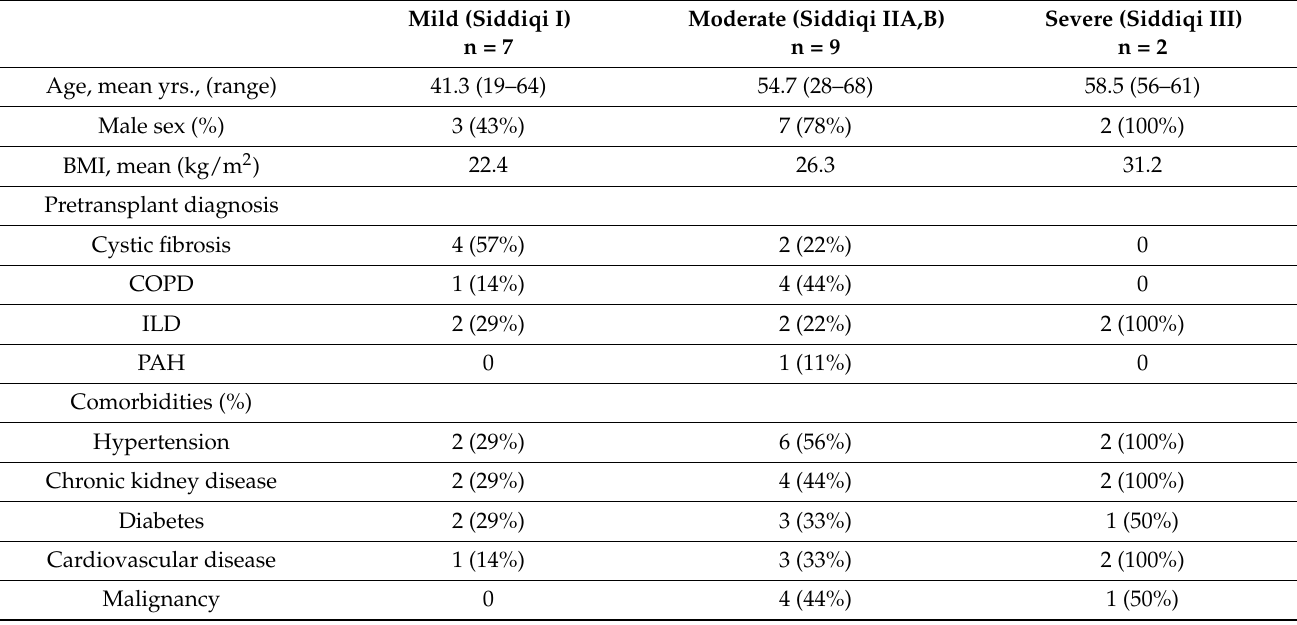
Table 1. Patient characteristics according to COVID-19 disease